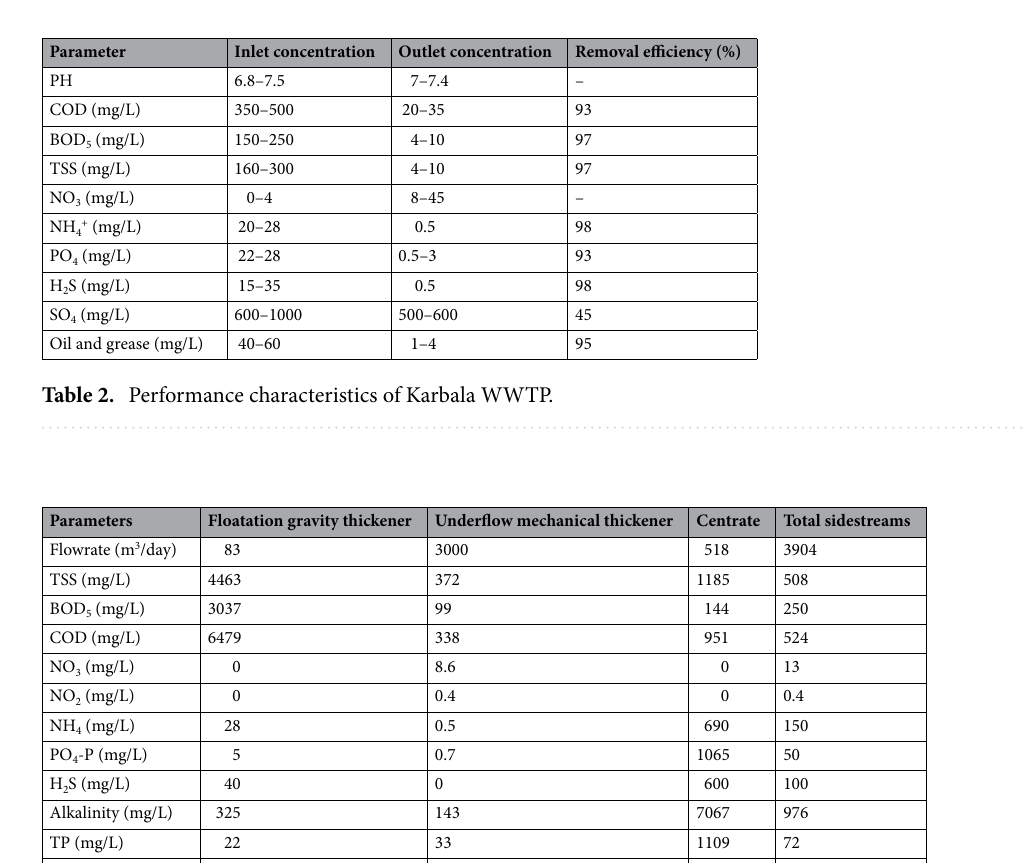
Figure 1. Schematic diagram of conventional A 2 /O system in Karbala WWTP.